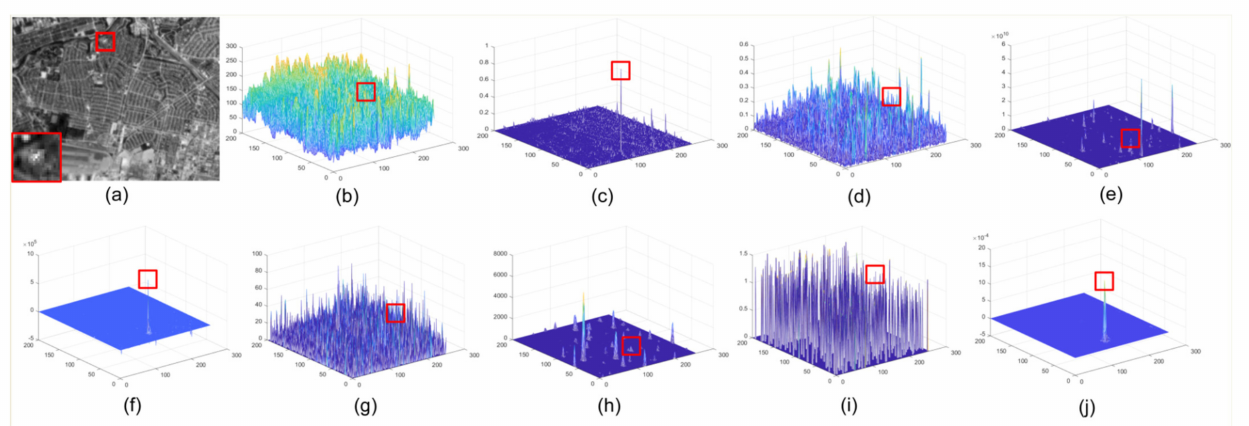
Figure 8. Detection results of different methods in Seq.3. ( a ) raw image, the details of target are magnified at the left bottom corner; ( b ) three-view of raw image; ( c ) result of STLCM; ( d ) result of STLCF; ( e ) result of FSM; ( f ) result of NSM; ( g ) result of STJP; ( h ) result of DNGM; ( i ) result of MLTC; ( j ) result of